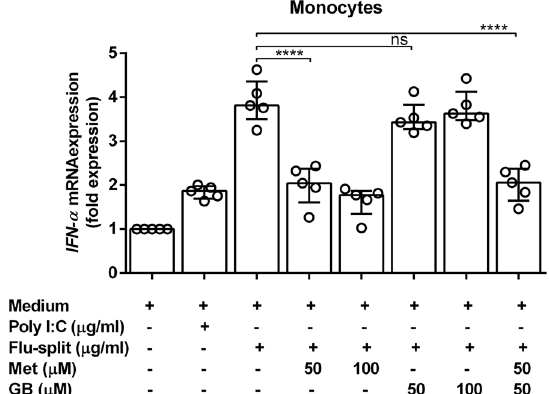
Figure 4. Metformin (but not glibenclamide) reduced IFN- α expression in human monocytes after seasonal vaccination. Monocytes from individuals without DM (non-DM; n = 5) were treated with metformin (Met) or glibenclamide (GB) or a combination of both for 30 min. Drug-treated monocytes were incubated with poly I:C or TIV (influenza split-virion) for 3 h before RNA extraction and determination of IFN- α expression by real-time PCR. Expression is shown as fold expression. Each point represents an individual. Statistical analyses were undertaken using one-way ANOVA. Horizontal lines represent the median with interquartile range. **** p < 0.0001; ns, not